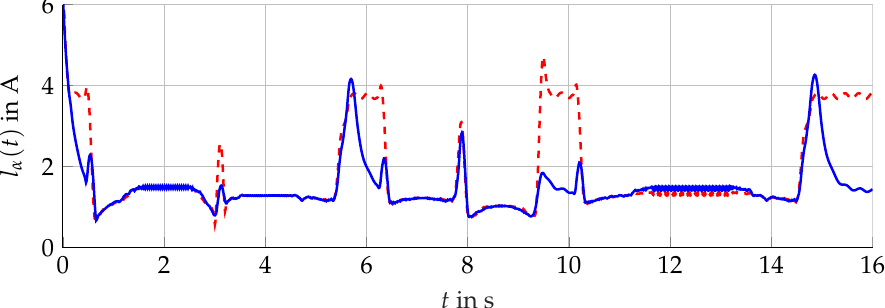
Figure 18. Interval width l α ( t ) of the bundle of observers only with configurations θ f ( t ) (red, dashed) compared with θ l ( t ) (blue, solid).